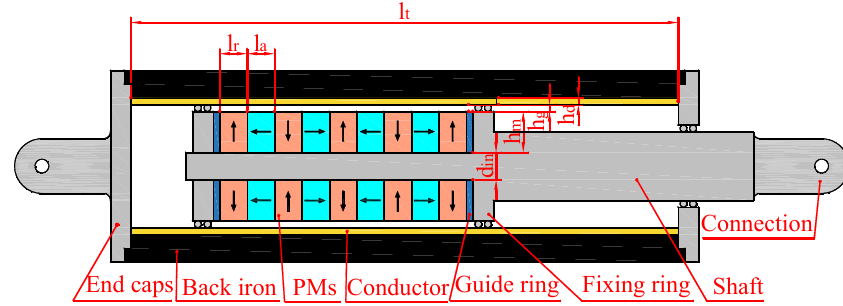
Figure 1. Longitudinal cross-section of the TLECD-HA.